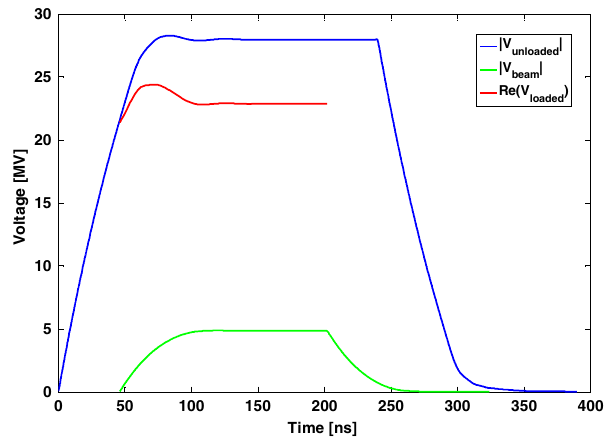
FIG. 6. Complex magnitudes of the unloaded voltage for a rectangular pulse of 240 ns (blue) and beam voltage for a train of 312 bunches (green), voltage seen by the main beam